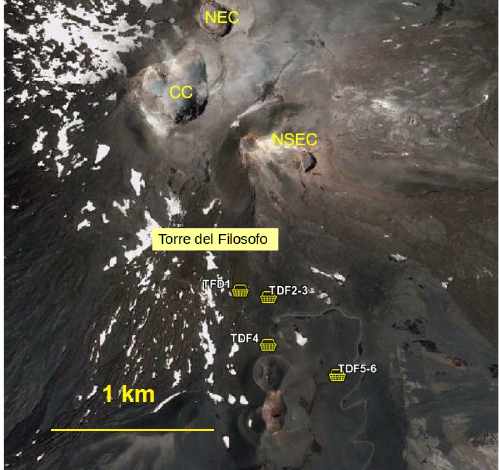
Figure 2. Map of Mount Etna summital zone in 2012 (aerial photography from Italian Geoportal). CC stands for Central Craters (Voragine and Bocca Nuova), NEC for northeast Crater and NSEC for new southeast Crater. Sampling sites (TDF1, TDF2-3, TDF4 and TDF5-6, where TDF stands for Torre del Filosofo) are pointed on the map.